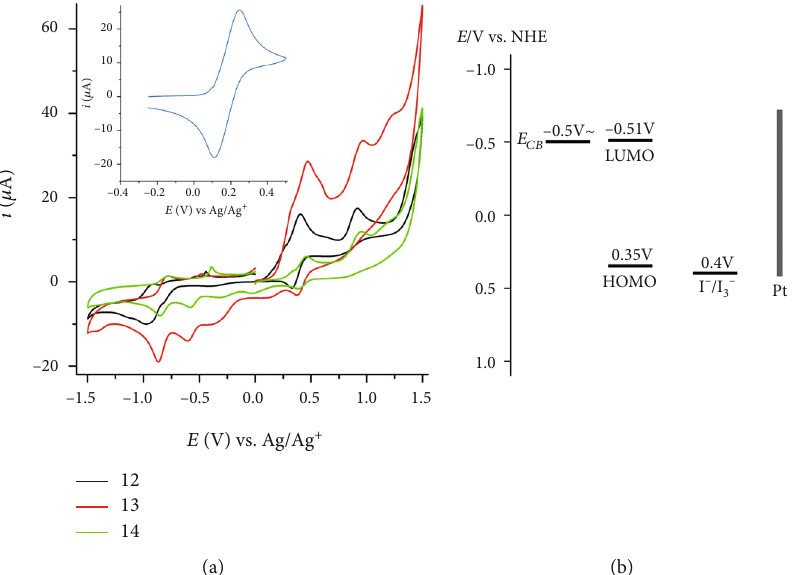
Figure 9: (a) Cyclic voltammogram of a glassy carbon electrode in 0.1 TBAPF voltammogram of ferrocene. (b) Energy diagram of TiO